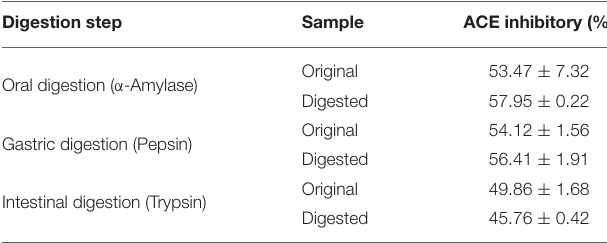
TABLE 1 | ACE inhibitory activity of FPQYLQYPY after in vitro gastrointestinal